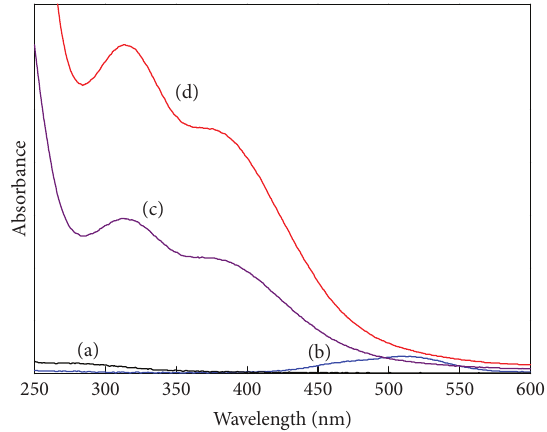
Figure 1: Optical absorption spectra of DABA, Co(II), and com- plexes in aqueous solution at room temperature (absorption spectra of DABA (a), Co(II) (b), DABA-Co(II) in N 2 (c), and DABA- Co(II) in O 2 (d). 𝐶 DABA = 4.0 × 10 −4 mol ⋅ dm −3 and 𝐶 Co ( II ) = 2.0 × 10 −4 mol ⋅ dm −3 ).